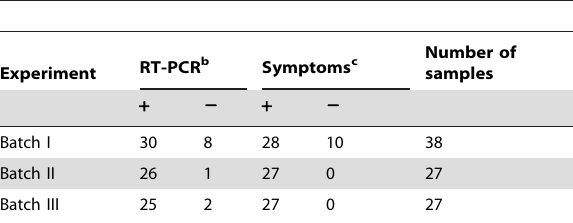
Table 3. Summary of the Nervous necrosis virus NNV detection results from the Linyuan a grouper fish farm by integrated microfluidic chip